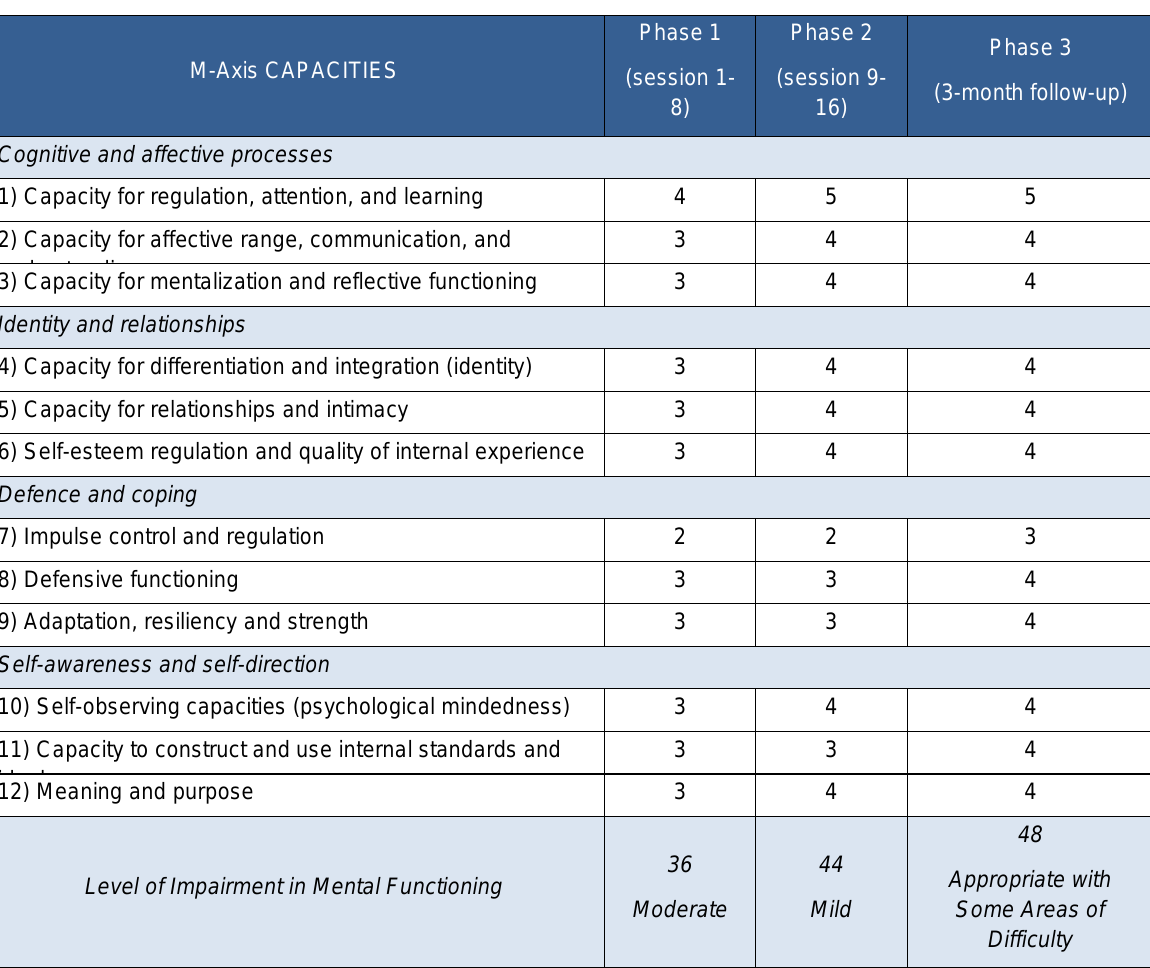
M-Axis CAPACITIES